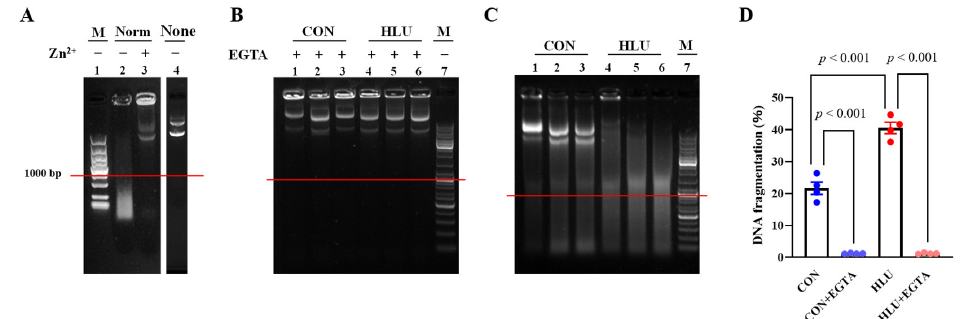
Figure 9. Activity of DNase X. ( A ) Lane 1: DNA Ladder (DNA molecular weight marker). Lane 2: Digestion solution which digested by muscle extraction (normal SOL muscle was extracted). Lane 3: Di- gestion solution which digested by the same muscle extraction as that in Lane 2 but containing 0.1 mM ZnCl 2 . Lane 4: Digestion solution which was digested by blank extraction (no muscle was extracted). ( B ) Lane 1–3: Digestion solution which was digested by CON-SOL muscle